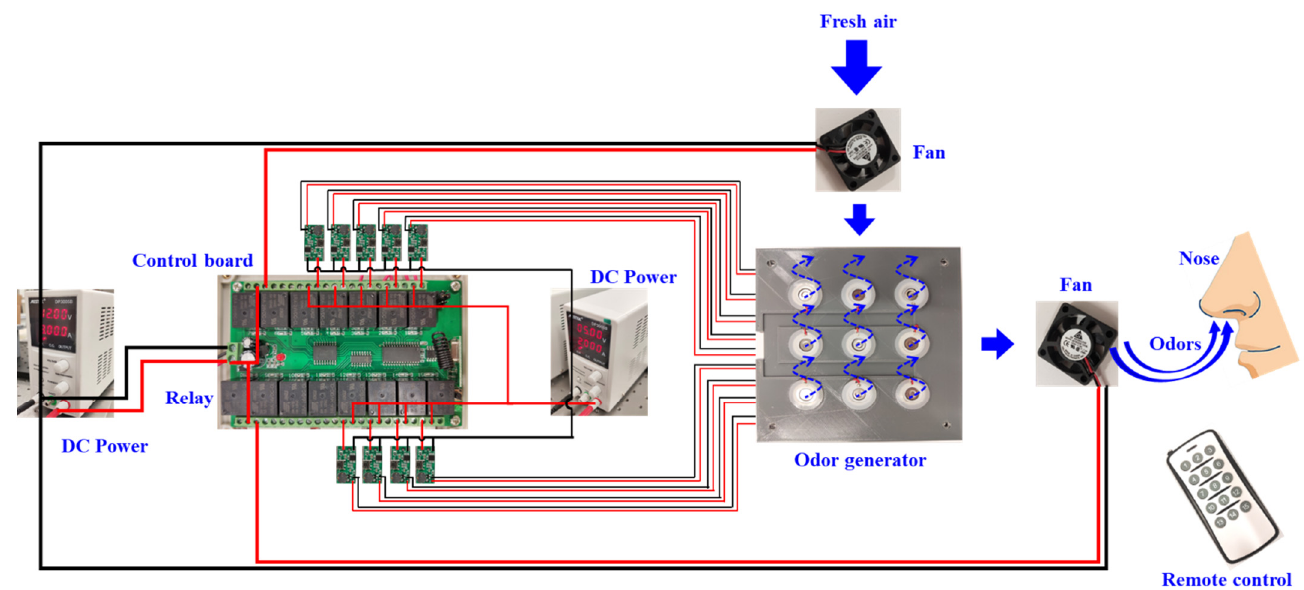
Figure 9. Control board of Flexible Odor-Releasing Device.